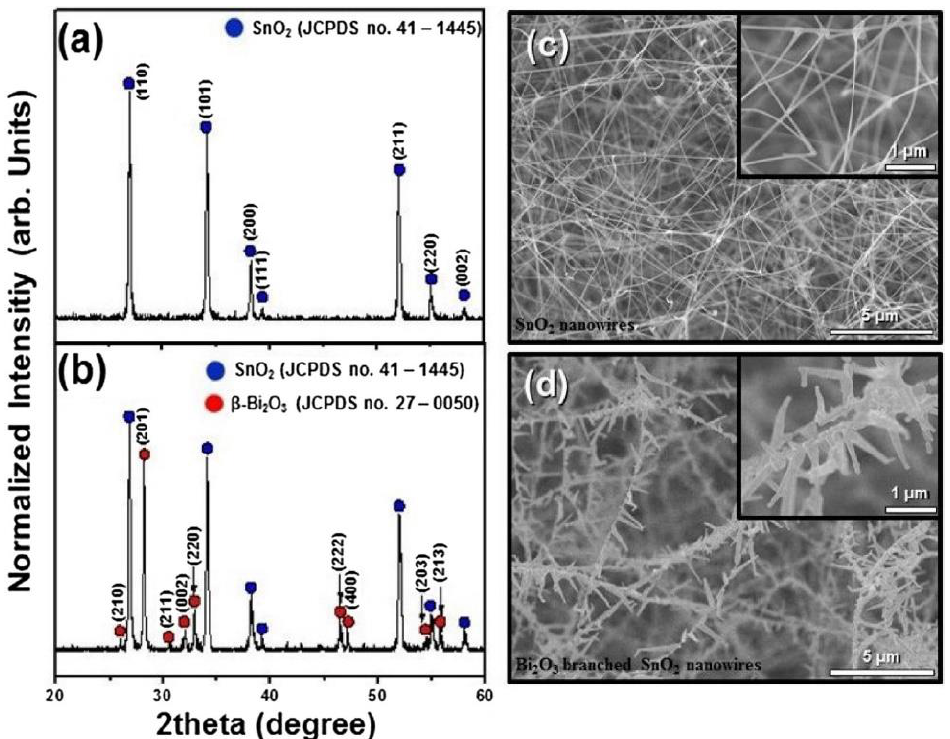
Figure 5. XRD spectra of ( a ) SnO 2 NWs and ( b ) Bi 2 O 3 -branched SnO 2 NWs. SEM images of ( c ) SnO 2 NWs and ( d ) Bi 2 O 3 -branched SnO 2 NWs. Reprinted with permission from Ref. [54]. Copyright 2018, Elsevier.